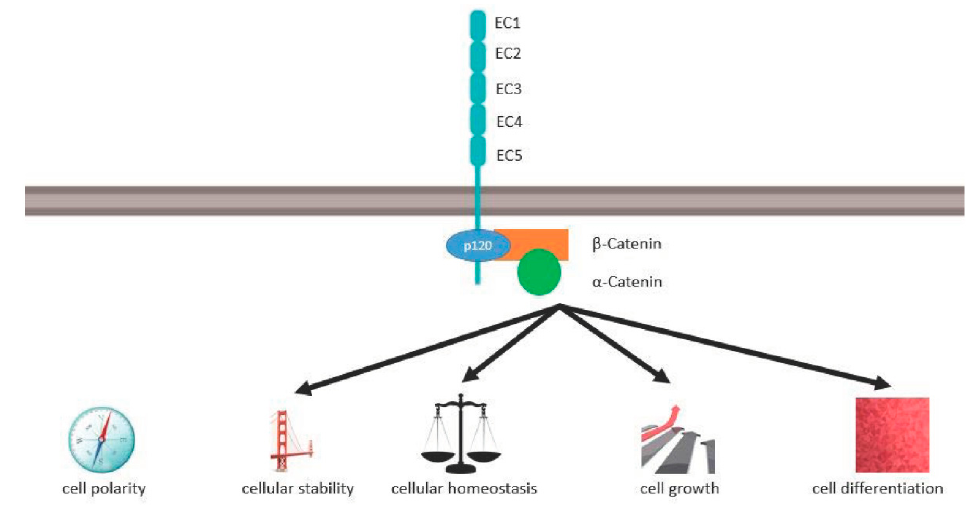
Figure 1. Role of E ‐ cadherin for cellular homeostasis, polarity and differentiation. Figure 1. Role of E-cadherin for cellular homeostasis, polarity and